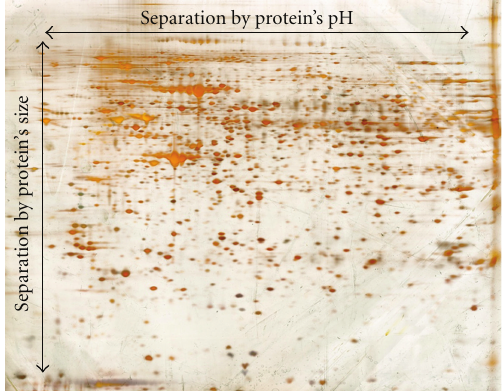
Figure 2: Gel-based proteomics reduces the complexity, of protein lysates by two-dimensional separation of proteins, that is, separa- tion by size and pH. This leads to a high resolution of single protein which facilitates the quantification of their spot size and the ex- traction of single proteins for subsequent mass spectrometry-based identification of the protein